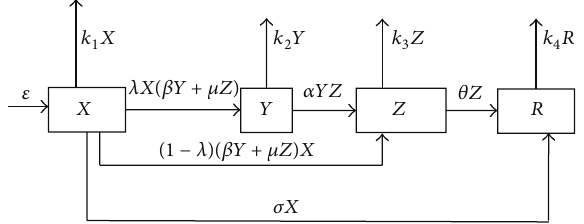
Figure 1: The flowchart of 𝑋𝑌𝑍𝑅 model for the rumor spreading